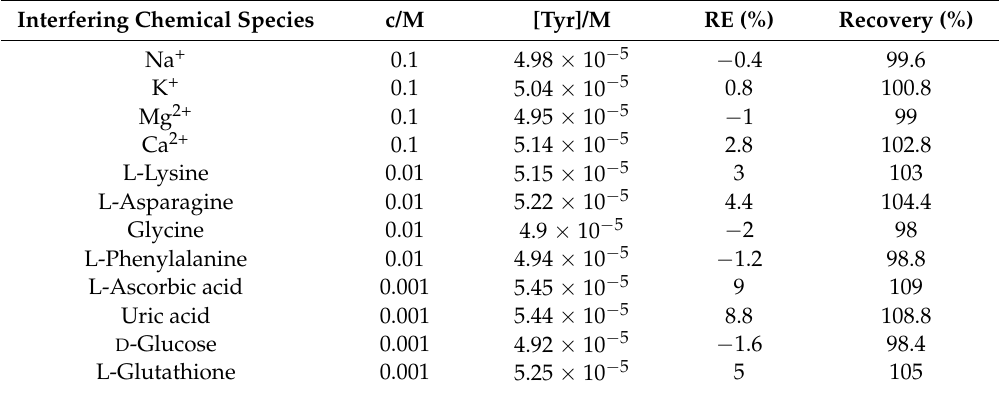
c—concentration of interfering chemical species; RE—relative error in determination of